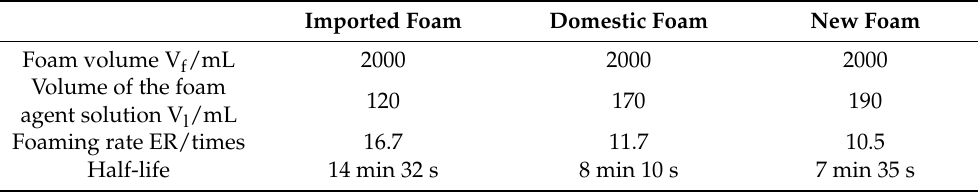
Table 5. Comparison of foaming agent half-life of the three foam agents.